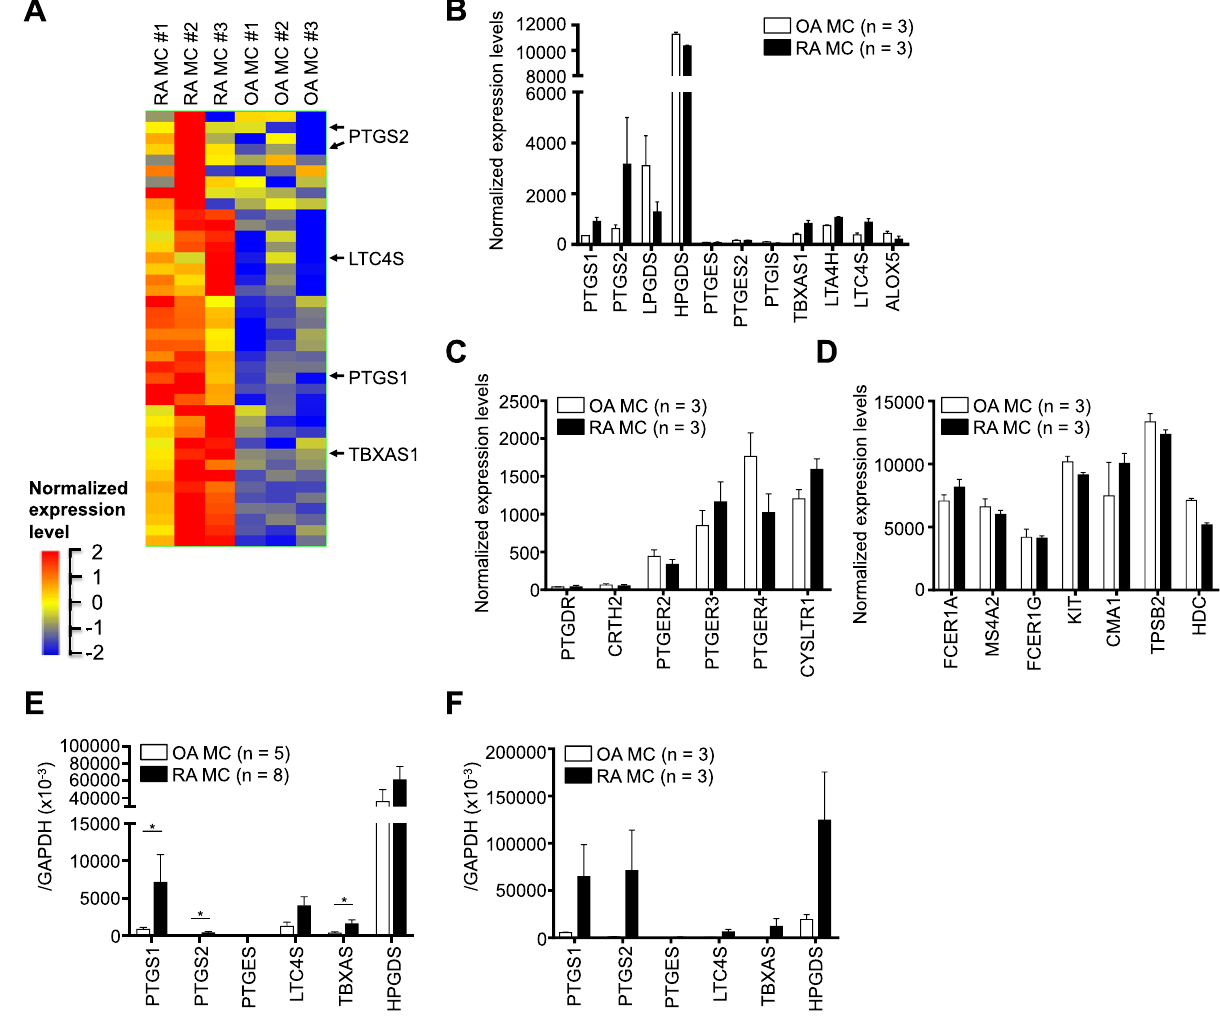
Figure 1. Comparison of gene expression profiles between synovial MCs from OA and RA patients. ( A ) A part of hierarchical clustering on the basis of the gene expression data in synovium-derived, cultured MCs obtained from three RA patients compared with MCs from three OA patients. Total RNA was isolated from the cultured MCs without any stimulus. Each row of colored bars represents one gene, and each column represents one donor. Colored bars show the magnitude of the response of each gene, according to the scale shown. Arrows indicate genes that are associated with enzymes involved in eicosanoid biosynthesis. ( B – D ) Comparison of gene expression levels of enzymes involved in eicosanoid biosynthesis ( B ), receptors for eicosanoid ( C ) and MC-related molecules ( D ) in synovium-derived, cultured MCs from three OA patients (open bars) and three RA patients (closed bars). Data are shown as normalized expression levels of DNA chip (mean ± SEM). ( E ) Comparison of gene expression levels of enzymes involved in eicosanoid biosynthesis in synovium-derived, cultured MCs obtained from OA (open bars, n = 5) and RA (closed bars, n = 8) patients. The data are shown as the ratio of the enzyme mRNA level to the GAPDH mRNA level (mean ± SEM). Significance was determined using the Mann–Whitney U test (* P < .05). ( F ) Comparison of gene expression levels of enzymes involved in eicosanoid biosynthesis in fleshly isolated, synovial MCs from OA (open bars, n = 3) and RA (closed bars, n = 3)